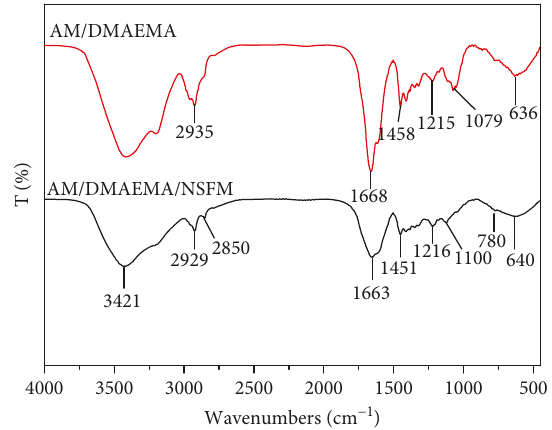
Figure 1: FTIR spectra of AM/DMAEMA and AM/DMAEMA/ NSFM